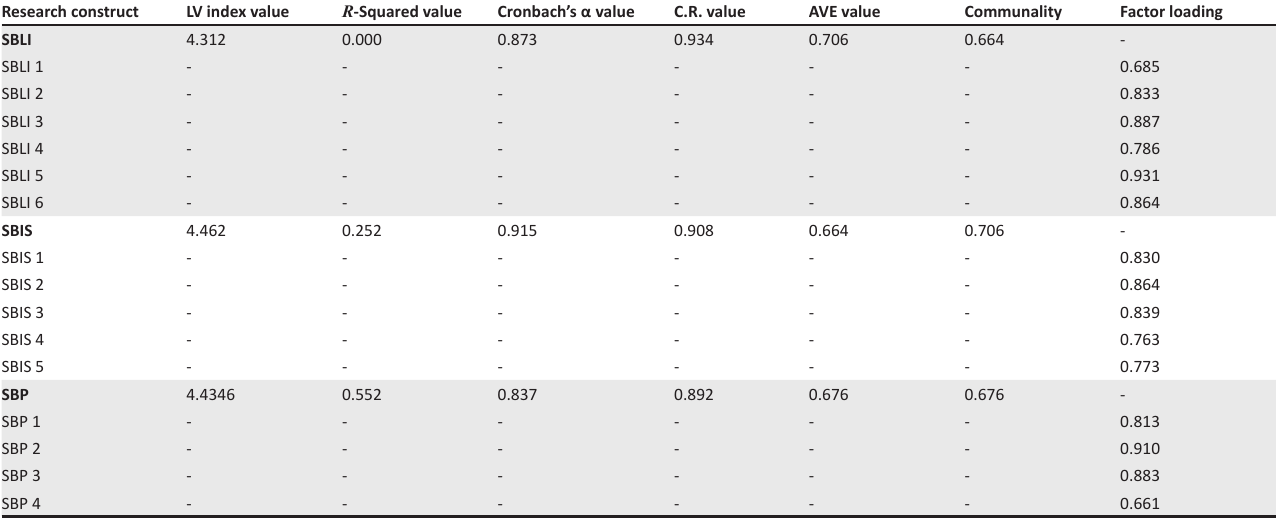
TABLE 2: Accuracy analysis statistics. Research construct